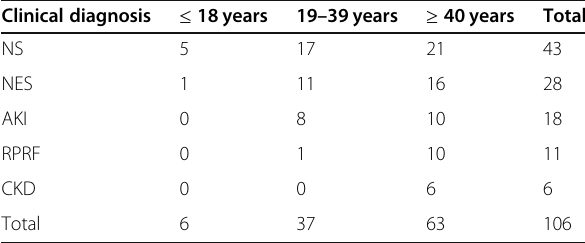
Table 2 Indications of biopsy among various age groups Clinical